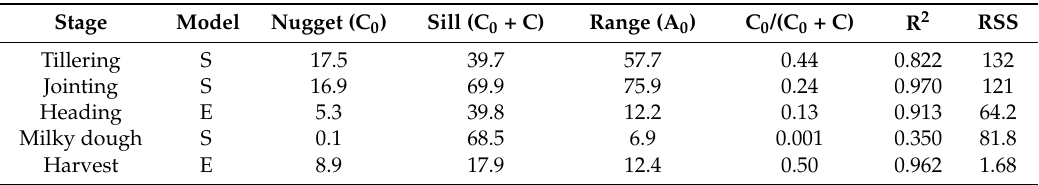
Table 1. Parameters of the semivariance model of volumetric moisture content (VMC) during the winter wheat growth stages.